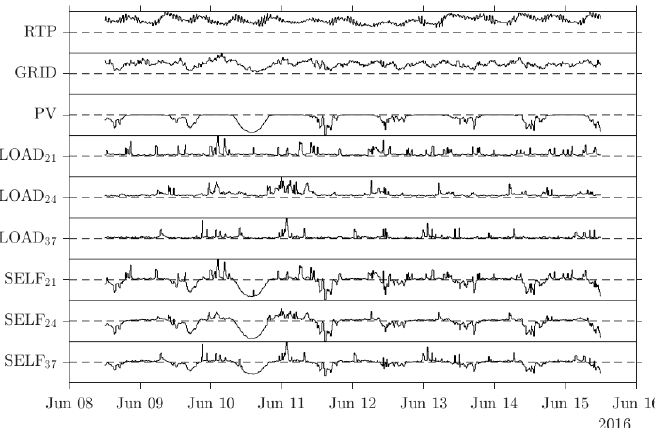
Figure 2. Used and normalized incentives to drive the optimization of the BESS for a one-week period: EXAA day-ahead spot-market price for electricity (RTP); total grid load at the slack node (GRID); photovoltaic generation (PV); individual household loads (LOAD) for household at node 21, 24, and 37 comprising a distributed storage system; individual total household consumption including load and photovoltaic generation (SELF) for household at node 21, 24, and 37 comprising a distributed storage system.